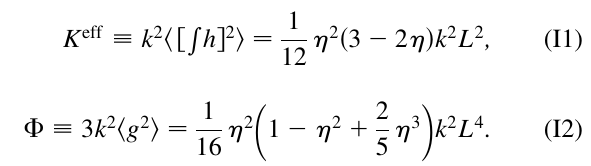
The 1 = 9 4 term can be neglected in practice.